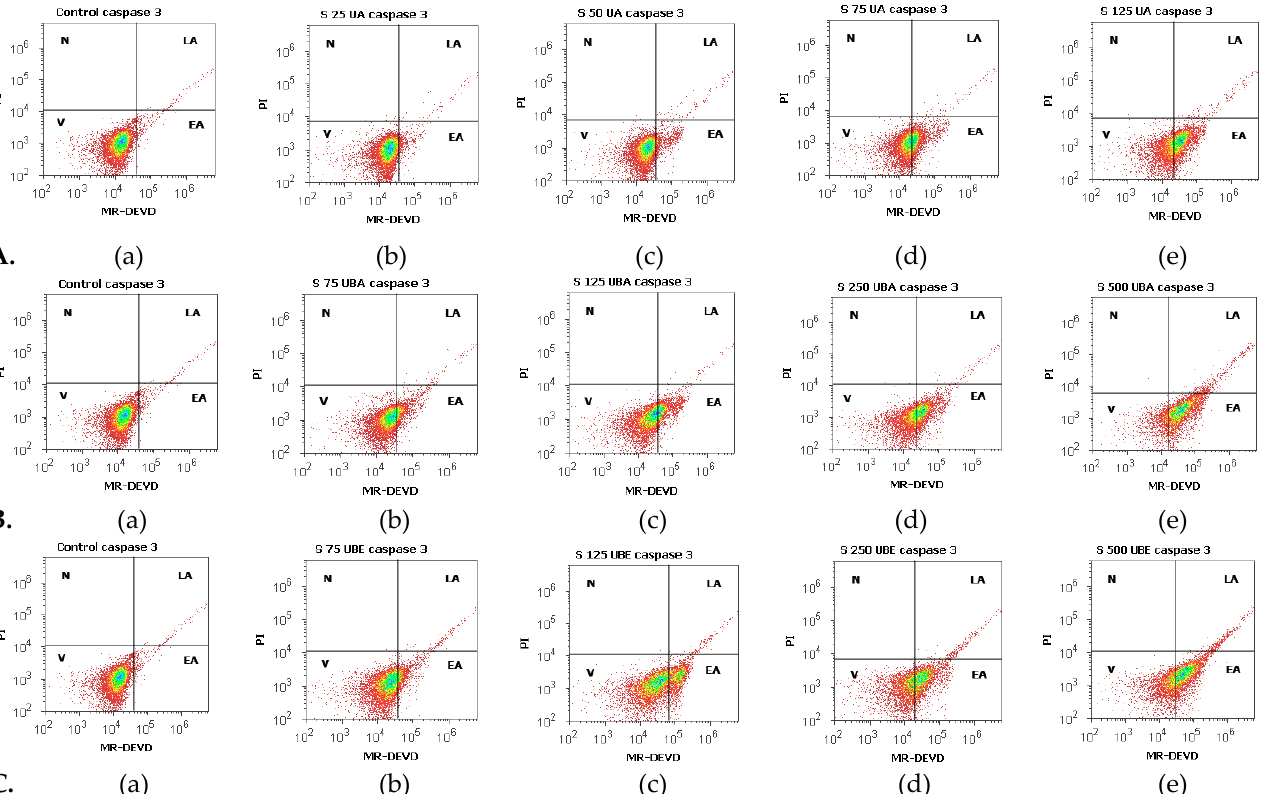
Figure 4. Caspase 3/7 activity status of UA, UBA, and UBE treatments in normal blood cell cultures. MR-DEVD/PI patterns of 1% DMSO as Negative Control ( A ( a ), B ( a ), C ( a )); A ( b – e ) UA 25, 50, 75, 125 µ g/mL; B ( b – e ) UBA 75, 125, 250, 500 µ g/mL; C ( b – e ) UBE 75, 125, 250, 500 µ